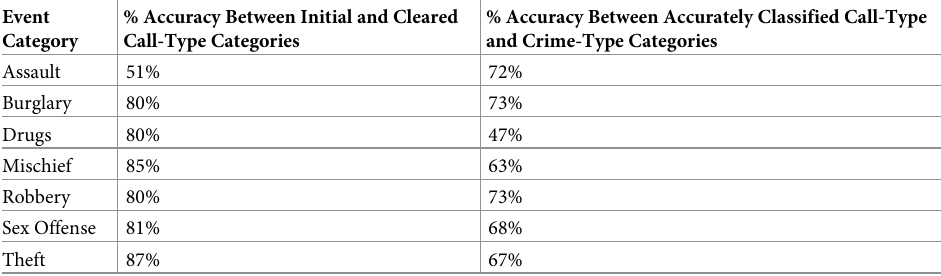
Table 3. Crime-related call-type categories and their classification accuracy